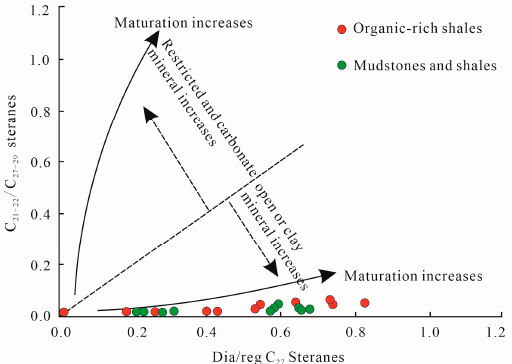
Figure 10. Cross-plot of C 21–22 /C 27–29 sterane versus dia/reg C 27 sterane ratios (modified from Ref. [31]).